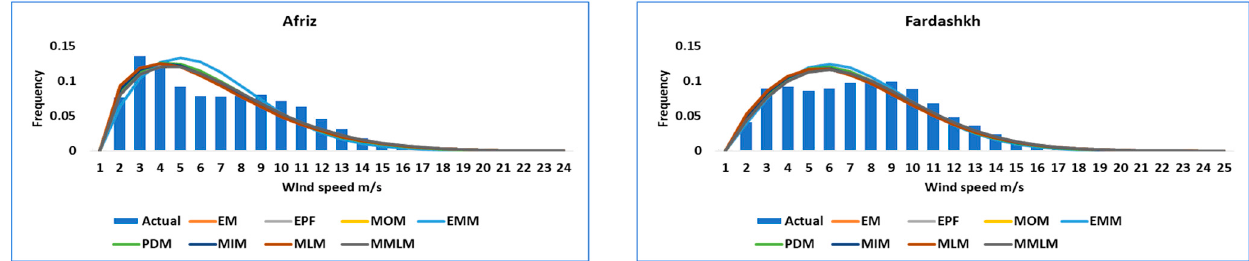
Figure 2. Weibull probability distribution of the sites. Then, the methods were ranked based on their performance when examined with statistical tests. Table 3 illustrates the best-performing methods for all sites in this study. Table 3. Best-performing Weibull